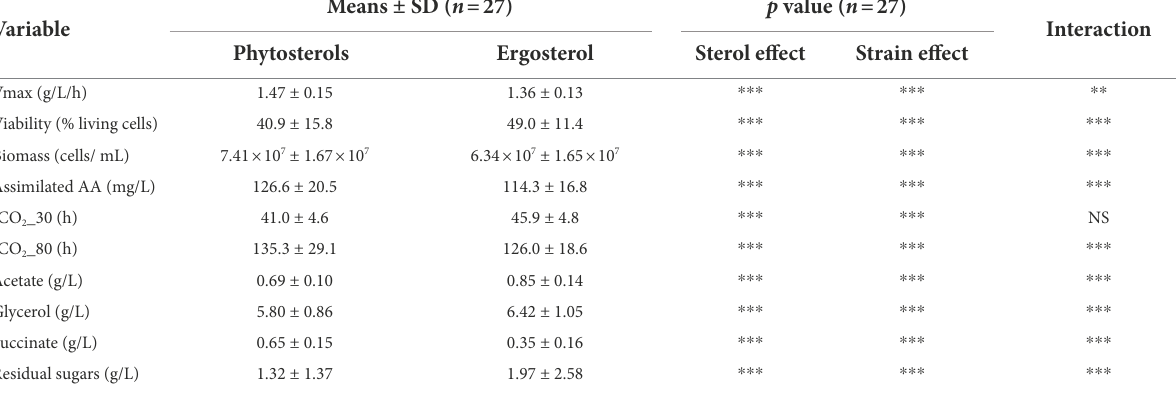
TABLE 2 Means, standard deviations (SD) and significance for the sterol limitation experiment.